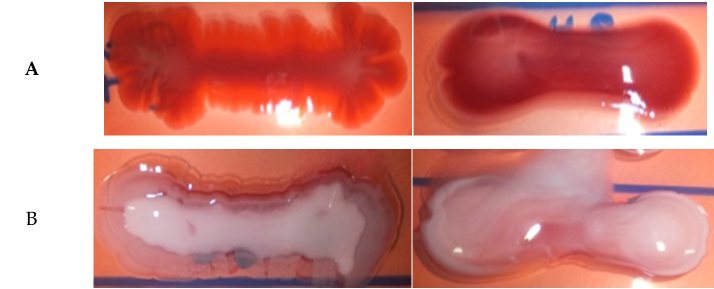
Figure 2. ( A ) From left to right: RDAR and PDAR phenotype at 37 °C after 72 h incubation; ( B ) From left to right: rough edge of RDAR phenotype and smooth shape of PDAR phenotype at 28 °C after 72 h incubation.